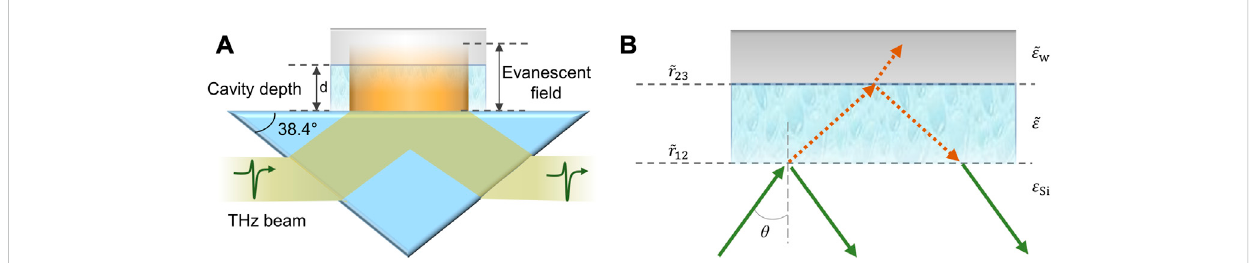
FIGURE 2 Schematic illustration of the interaction mechanism between the THz evanescent fi eld and sample and M-chip. (A) THz evanescent fi eld (in orange color) occurs at the prism-substance interface, penetrates the cavity, and enters the upper wall of the M-chip. The angle of ATR prism slant side is 38.4 ° . ThesubstanceinthecavityoftheM-chipcanbeeitherair(i.e.,reference)oraqueoussample.Aprism-substanceinterfaceandasubstance-PDMSupper- wallinterfaceareformed.AsthesidewalloftheM-chipdoesnotin fl uencetheanalysisinourcase,itisnotshownforsimplicity. (B) ~ r 12 and ~ r 23 arethe Fresnel ’ s re fl ection coef fi cients of prism-substance interface and the substance-PDMS upper-wall interface, respectively. ~ ε w , ~ ε , ε Si denote the complex dielectric constants of the PDMS, substance in the cavity, and silicon prism, respectively. ~ E in and ~ E out are the incident and emergent beams, respectively, and ~ r is the ultimate Fresnel ’ s re fl ection coef fi cient of the two-interface system. θ is the incident angle of the THz beam in the